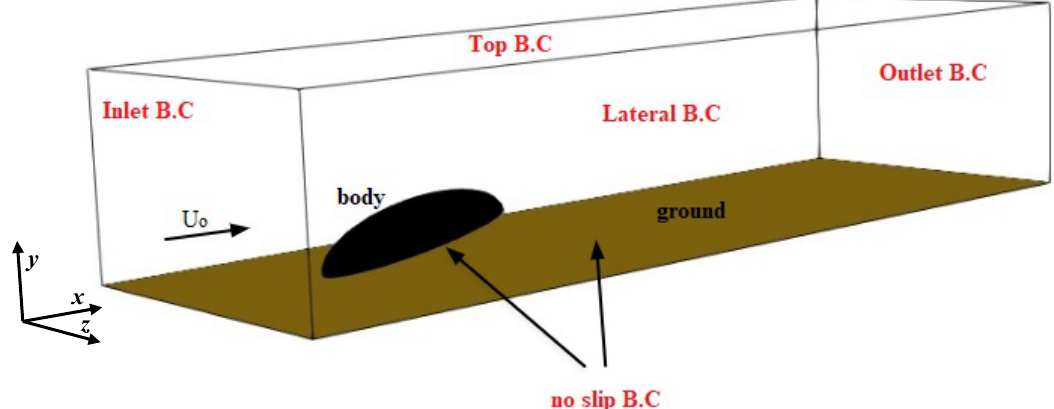
Figure 2. Wireframe image of the computational domain and boundary conditions (B.C.). The axes of the solid semi-ellipsoidal body are: a x = 8mm, a y = 3 mm, and a z = 3mm, typical of real beetles. Lateral and top B.C. are implemented as a symmetry condition, which effectively imposes no flow through these boundary surfaces. In terms of the velocity field, these conditions are equivalent to assuming wall slip, U · n = 0, where n denotes the normal to each symmetry surface.